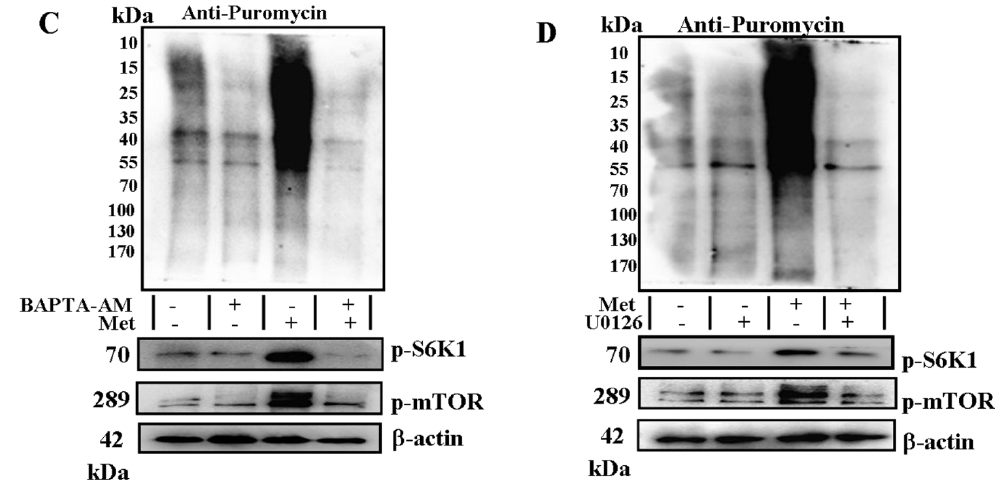
Figure 3. Met regulation of the PLC-Ca 2+ -ERK1/2 signal transduction process was essential for